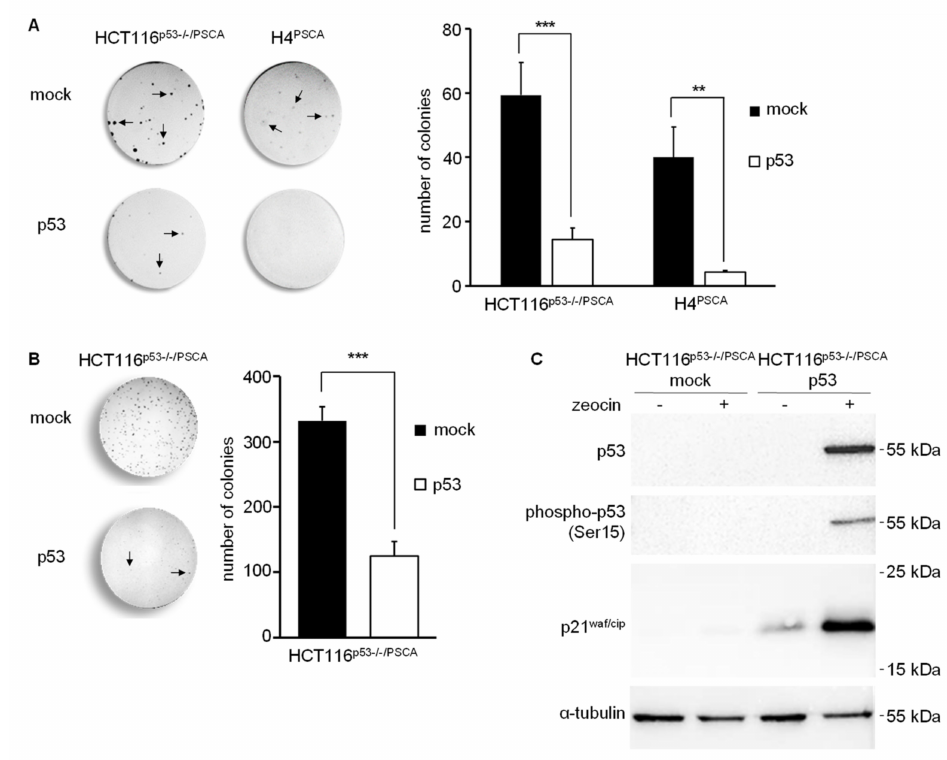
Figure 5. scFv(AM1)-P-BAP-guided transposition of TP53 in p53-deficient, PSCA-positive tumor